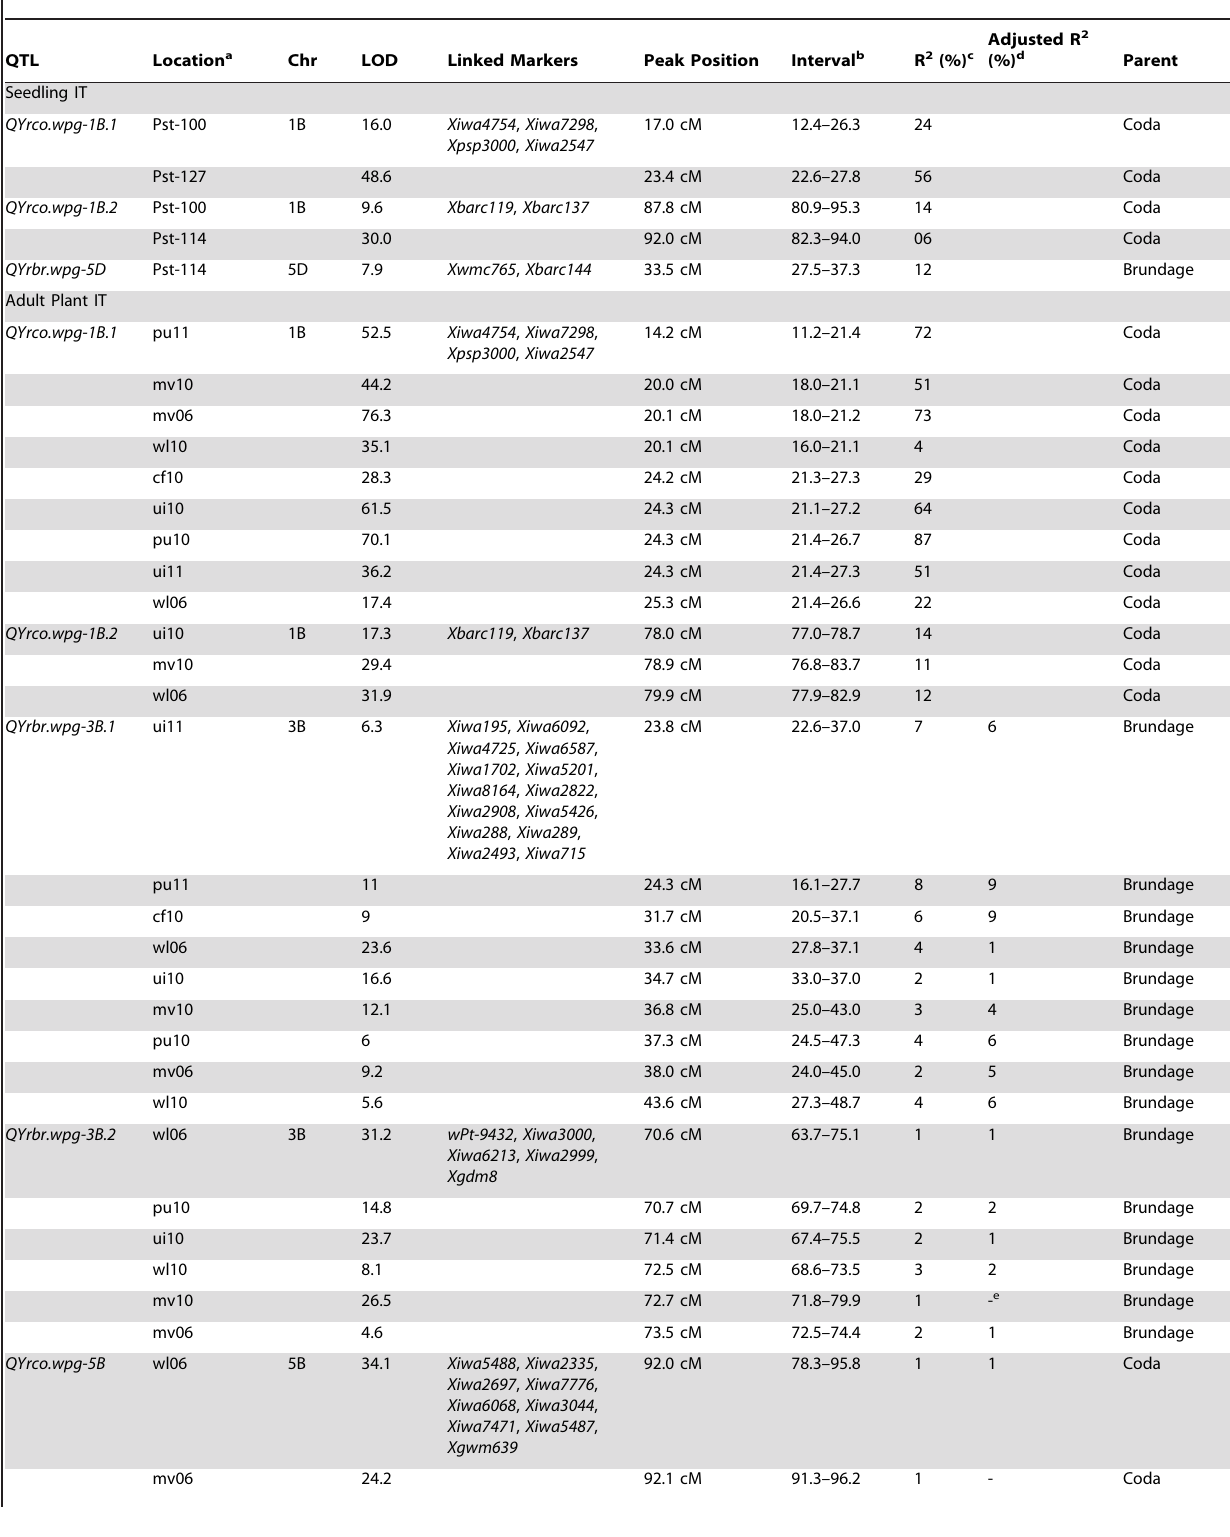
Table 1. Significant quantitative trait loci for stripe rust resistance identified by composite interval mapping in the Coda by Brundage recombinant inbred line mapping